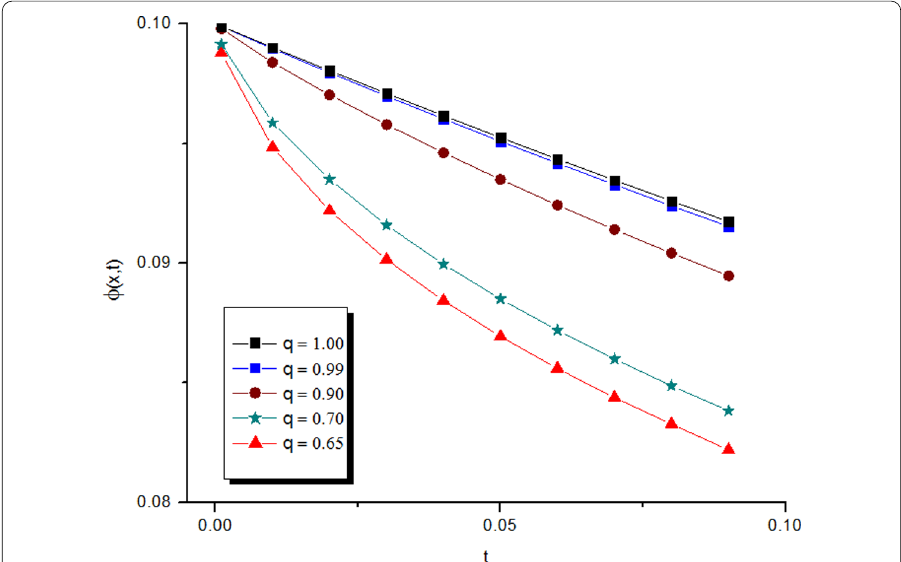
Figure 1 Simulation of φ ( x , t ) for Caputo fractional operator when x =